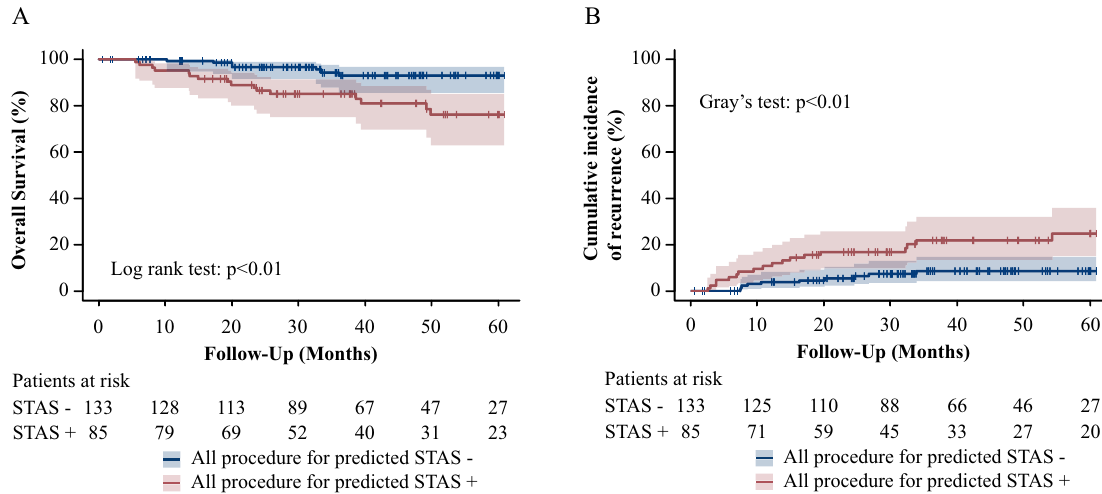
Figure 6. (R version 3.5.1, R Core Team (2018). R: A language and environment for statistical computing. R Foundation for Statistical Computing, Vienna, Austria. URL http:// www.R- proje ct. org/). Survival curves based on the model predicted by radiomics in all procedure. Shaded areas represent 95% confidence limits. ( A ) The OS in all patients. ( B ) The CIR in all